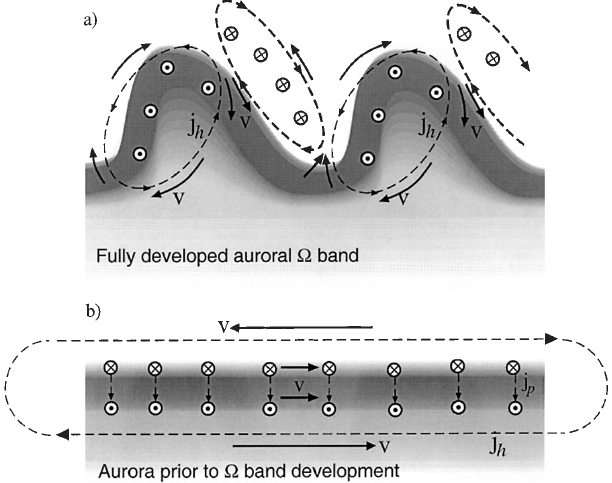
Fig. 8. a Schematic representation of auroral omega bands. Shaded regions represent bright aurora, dashed lines indicate ionospheric Hall currents, heavy solid arrows indicate convection flow direction, the length of the line is an indicator of flow strength. Upward FAC ( dotted circles ) and downward FAC ( crossed circles ) are also shown but Pedersen currents have been omitted for clarity. b A simplified interpretation of the region 1–region 2 currents before the advent of instability. Currents, flows and FACs and bright auroral regions are denoted as in